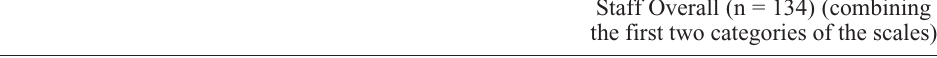
Staff Overall (n = 134) (combining the first two categories of the